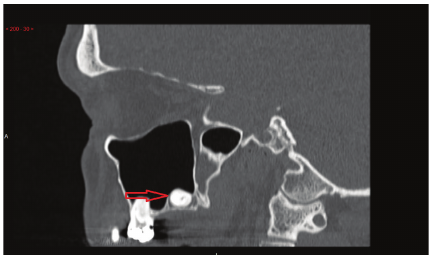
Figure 2: Sagittal view of the CT-scanner showing hyperdense material in the floor of the left maxillary sinus consistent with an ectopic third